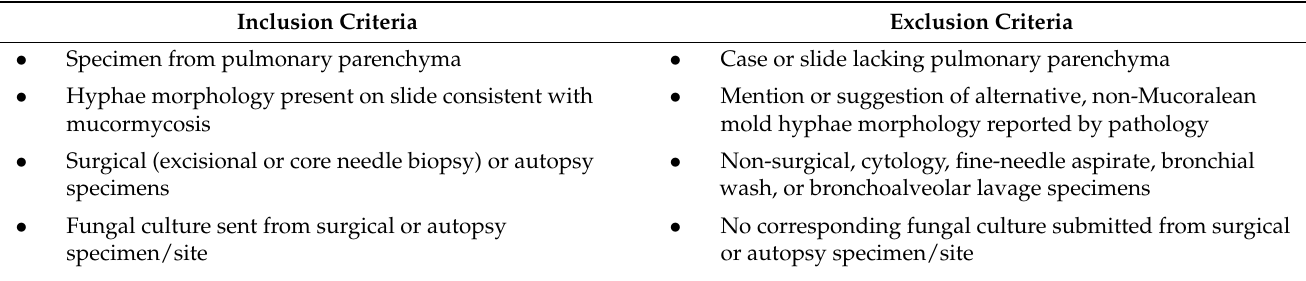
Table 1. Inclusion and exclusion criteria applied to histopathology